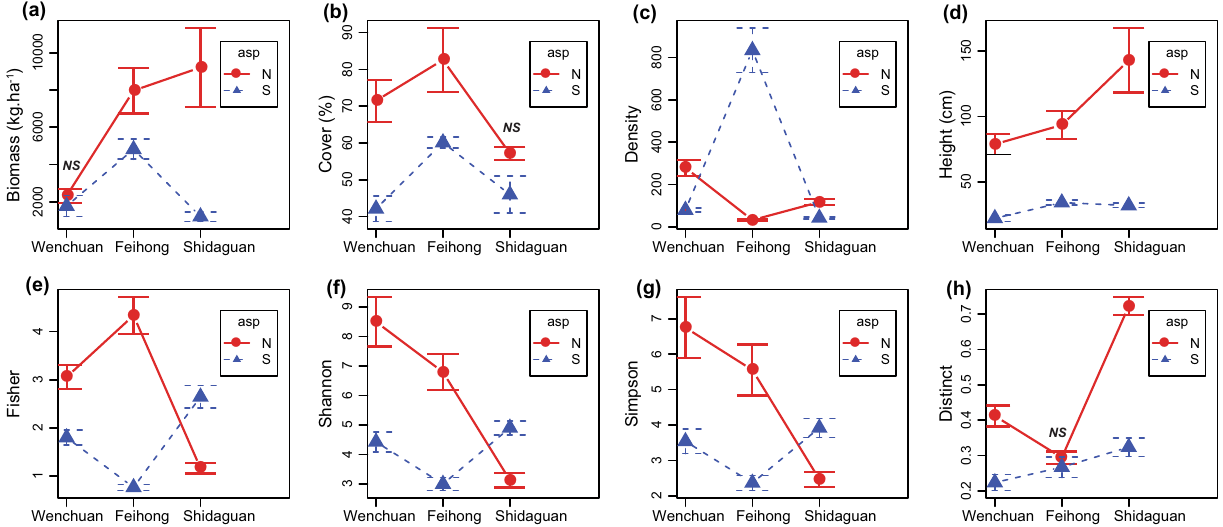
Figure 2. Comparison of vegetation structure a biomass, b coverage, c height, d density and biodiversity, e Fisher’s α, f Shannon diversity, g Simpson diversity, and h distinct between north- (red) and south-facing (blue) slopes for each site using one-way ANOVA.